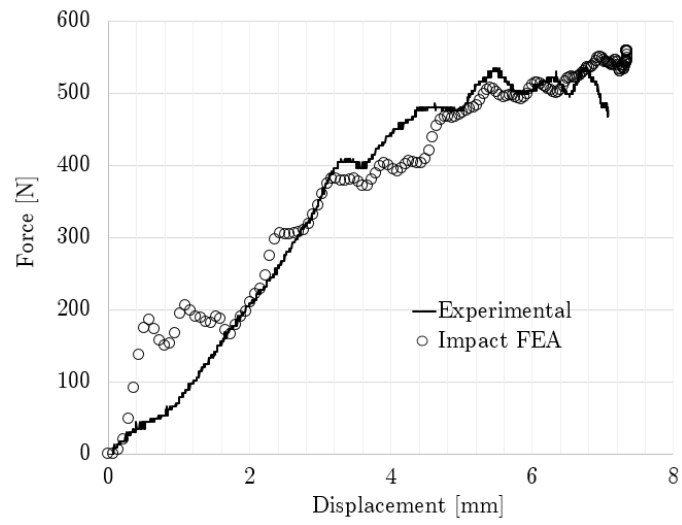
Figure 9. Impact force–displacement curve comparison for non-graded lattice.